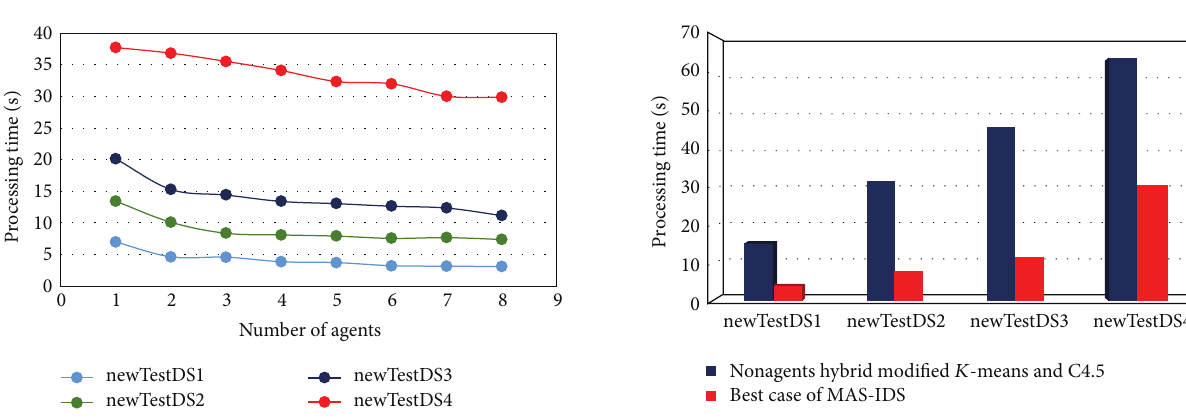
Figure 9: Time required to process the testing datasets in relation to the number of agents.